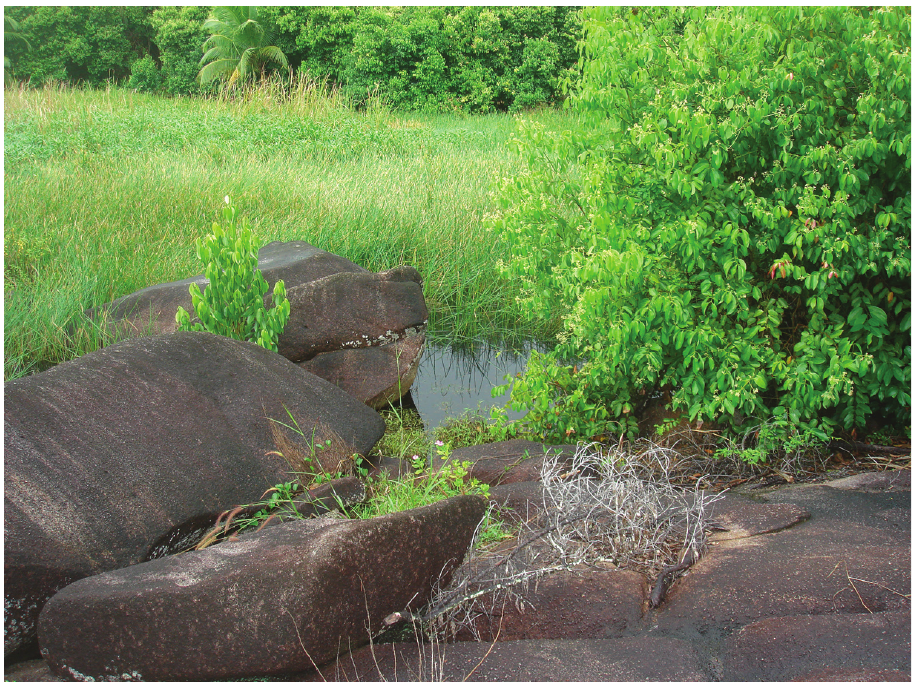
Figure 20. Habitat of Hydraena mahensis Scott, 1913. Swamp at Petite Police Bay,